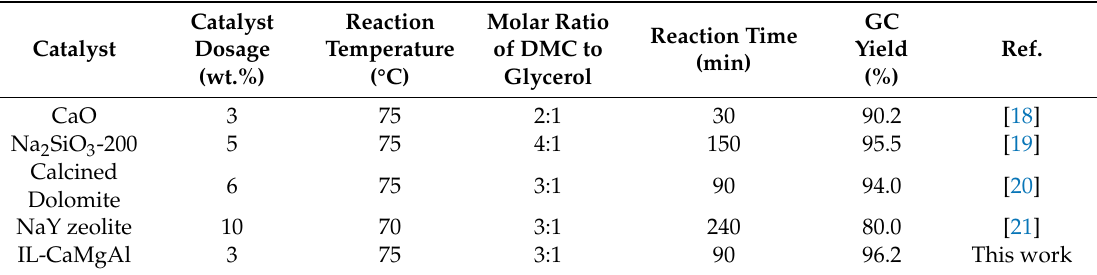
Table 3. Comparison of IL-CaMgAl with reported catalysts in transesterification of dimethyl carbonate (DMC) and